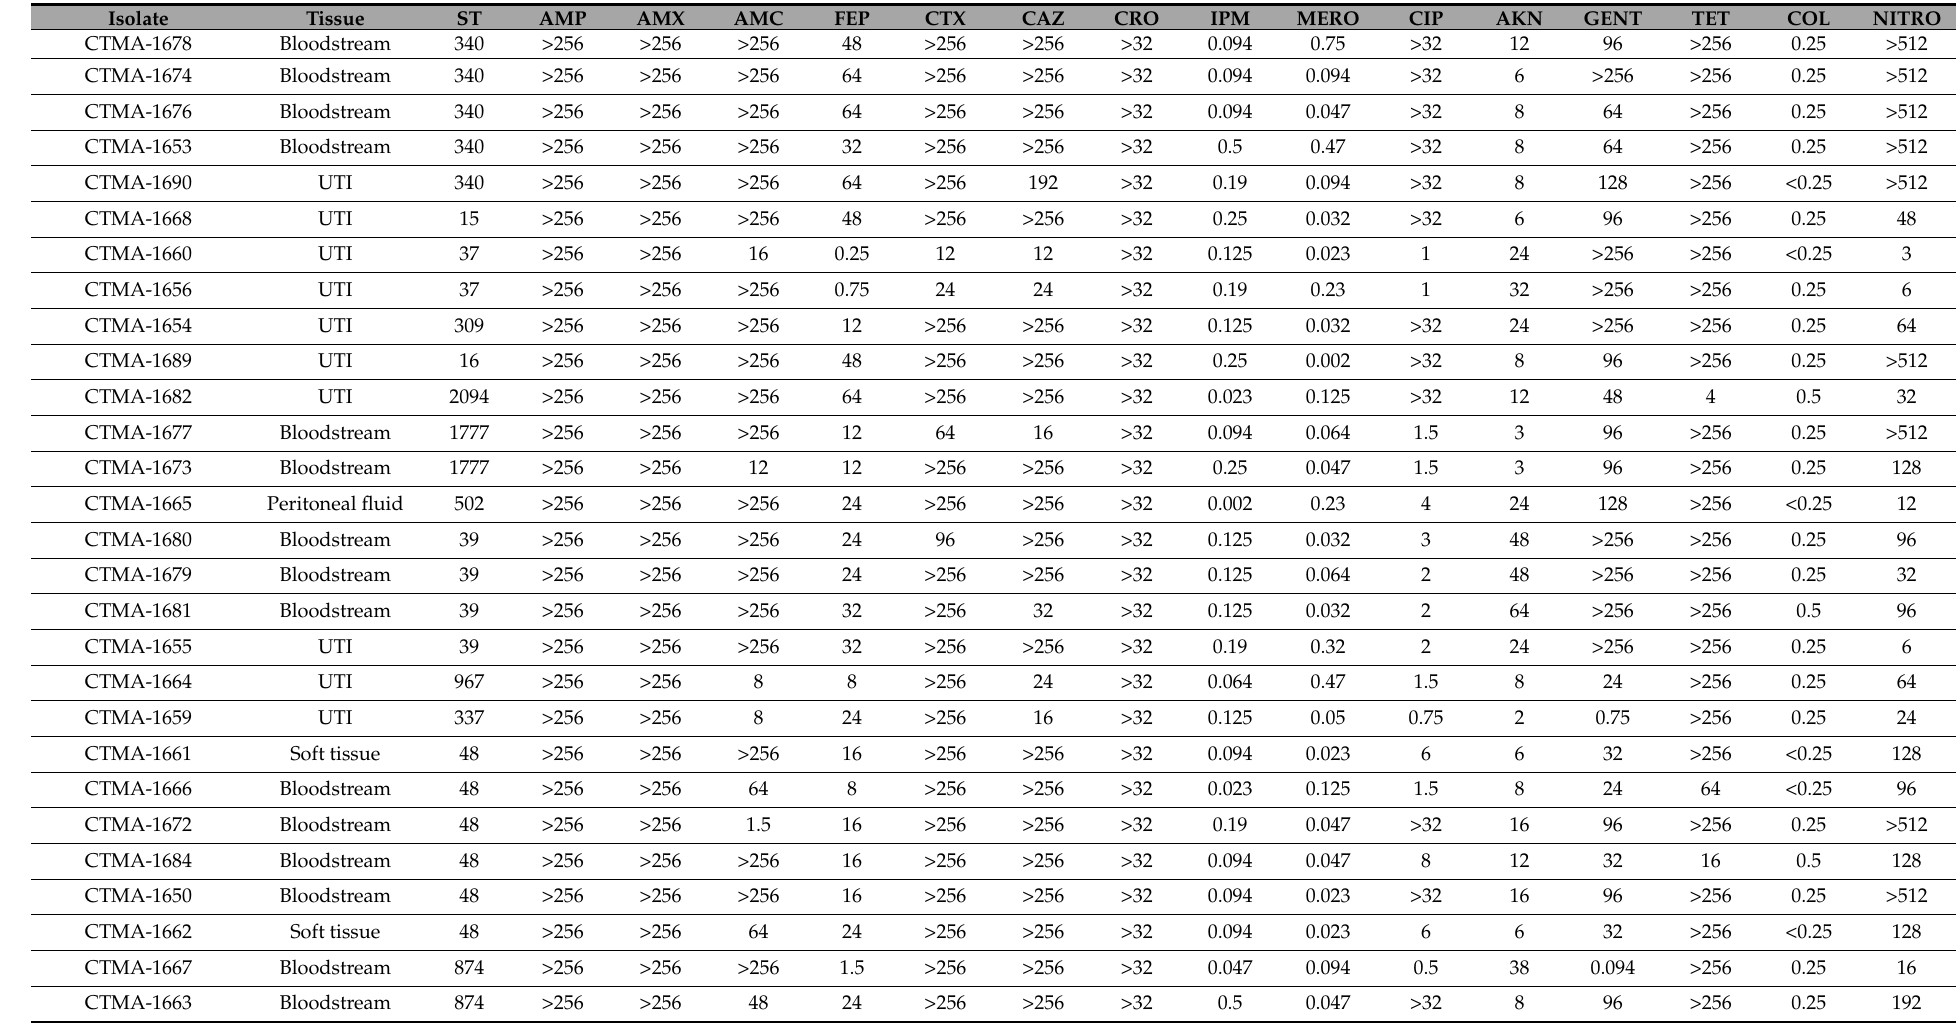
Table 1. Antimicrobial susceptibility profiles of ESBL-producing K. pneumoniae isolates (n = 37) from the DRC. MIC values (mg/L) for tested antimicrobial